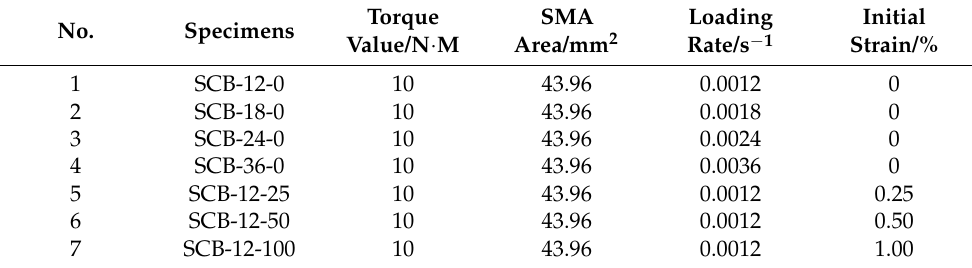
Table 1. Main specimen